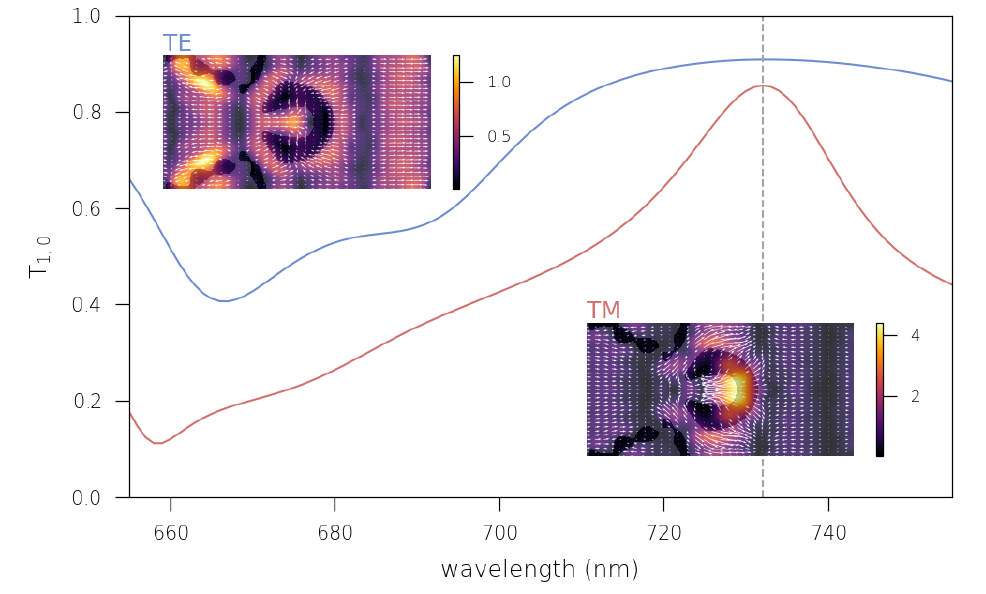
Figure 4. Transmission spectra in the ( 1,0 ) order for the optimized metasurface as a function of wavelength for TE (blue curve) and TM polarization (red curve). The insets show the norm of the Poynting vector (colourmap) and its transverse components (arrows) at the target wavelength directly above the metasurface ( z = 350